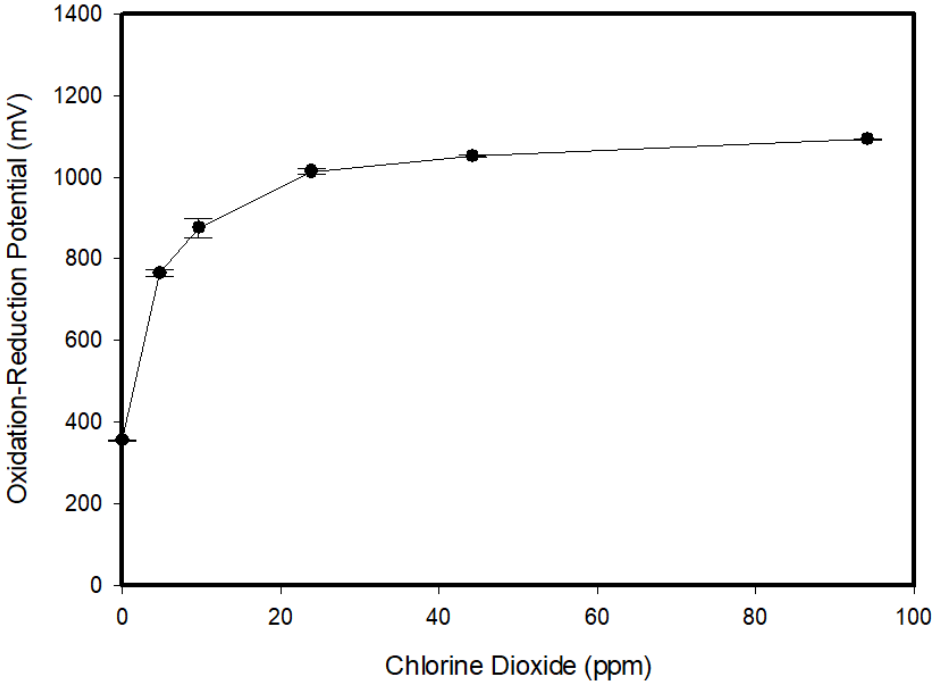
Figure 3. The relationship between the ClO 2 concentration of ACD and ORP in